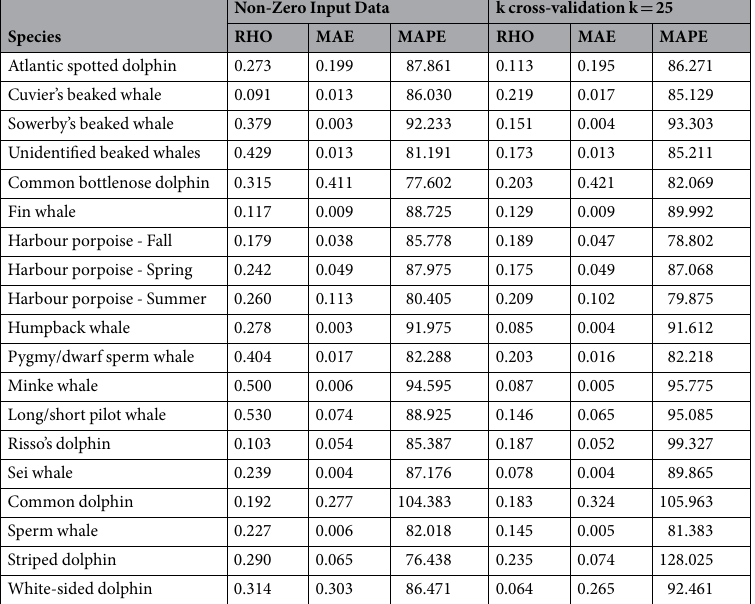
Table 2. Results of diagnostic tests to evaluate fit of the habitat models. RHO = Spearman’s rank correlation coefficient; MAE = Mean absolute error; MAPE = Mean absolute percentage error. Fit threshold values were taken from Kinlan et al . 49 where: =